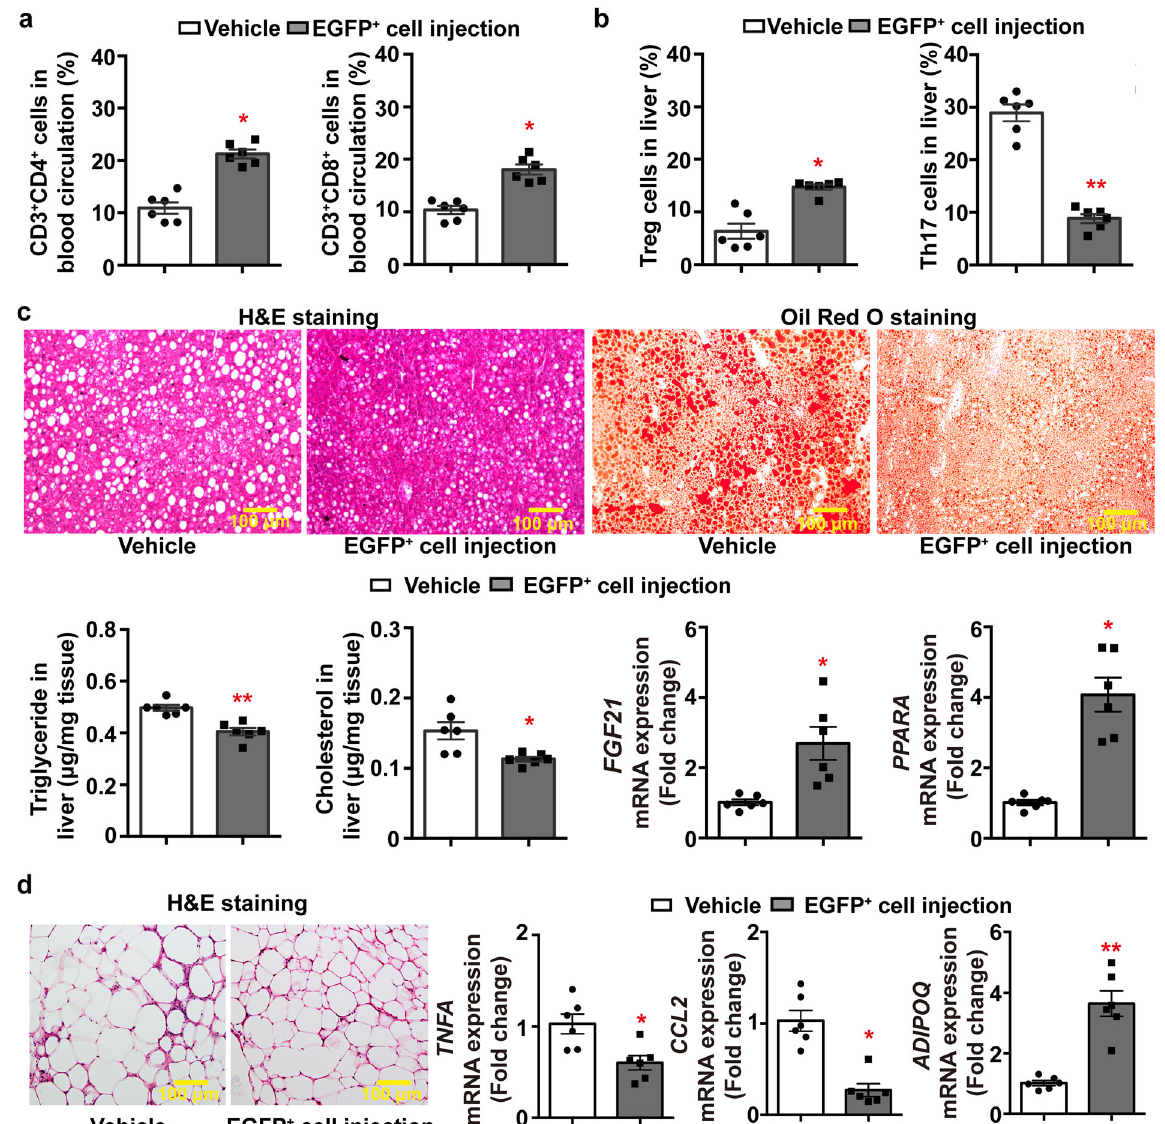
Fig. 6 Treatment with adiponectin-expressing tTreg precursors alleviates HFD-induced tissue injuries. Vehicle or adiponectin-expressing EGFP + cells [30000 cells/ mouse ] isolated from Adn-Cre/ROSA mT/mG mice were injected via tail vein into 4-week-old WT mice, which were then subjected to HFD feeding for another 12 weeks. At the end of treatment, blood, liver, and epididymal adipose tissue were collected for analyses. a Flow cytometry was performed to analyze the amount of CD3 + CD4 + and CD3 + CD8 + cells in the blood circulation for comparison. b Flow cytometry was performed to compare the amount of Treg and Th17 cells in liver tissues for comparison. c Hematoxylin and Eosin [H&E] or Oil Red O staining were performed for liver tissue sections to evaluate the accumulation and distribution of lipid droplets ( top ). The triglyceride and cholesterol contents in liver samples were examined by biochemical assays ( bottom left ). QPCR was performed for measuring the gene expression levels of FGF21 and PPARA in liver ( bottom right ). d H&E staining was performed for epididymal adipose tissue sections ( left ). QPCR was performed for measuring the gene expression levels of TNFA , CCL2 and ADIPOQ in epididymal adipose tissues ( right ). Data are presented as mean ± SEM; *, P < 0.05 and **, P < 0.01 vs corresponding vehicle controls ( n = 6 biologically independent samples from different animals of independent